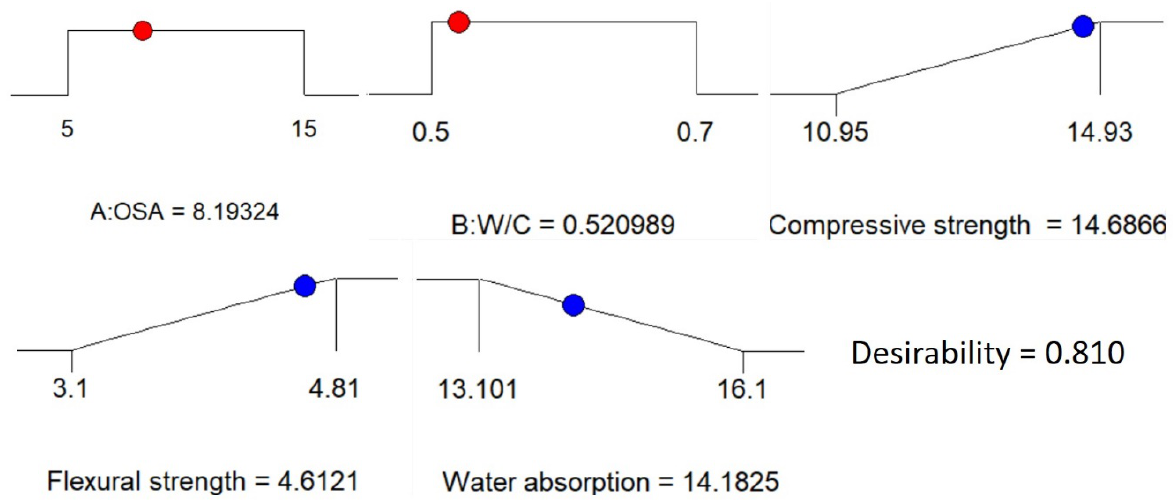
Figure 11. Optimization ramps of the geopolymer mortar.